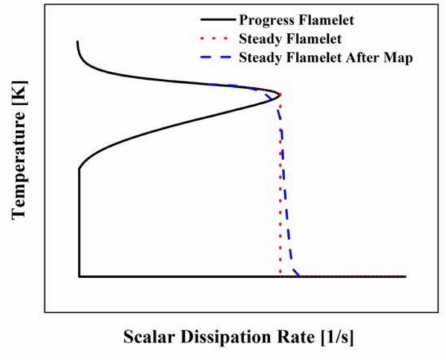
Figure 7. Schematic diagram of the comparison between the progress flamelet and steady